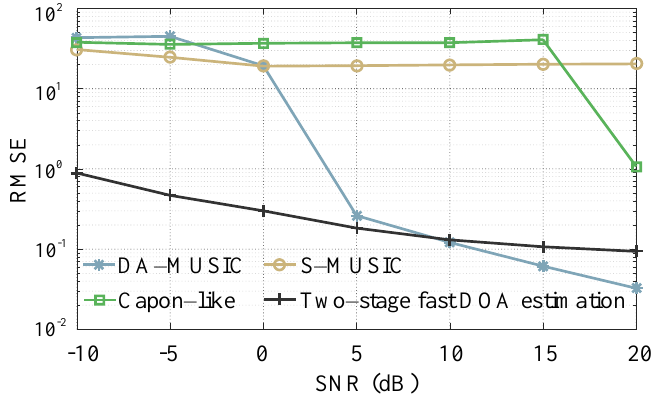
Figure 7. RMSE versus SNR.